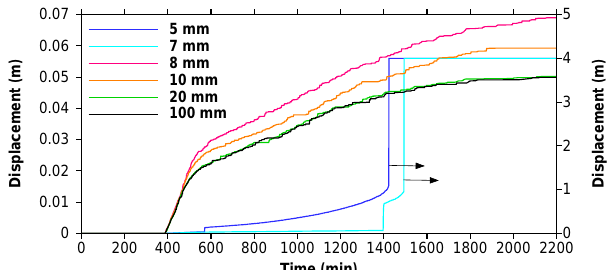
Figure 18. Effect of maximum root-size diameter (5 to 100mm) on displacement at the slope center ( x = y = 0) for a 3m spaced, DBH = 40cm, tree-covered slope. The 5 and 7mm simulations both yield a landslide and their displacement curves plot on the ver- tical axis to the right (indicated by